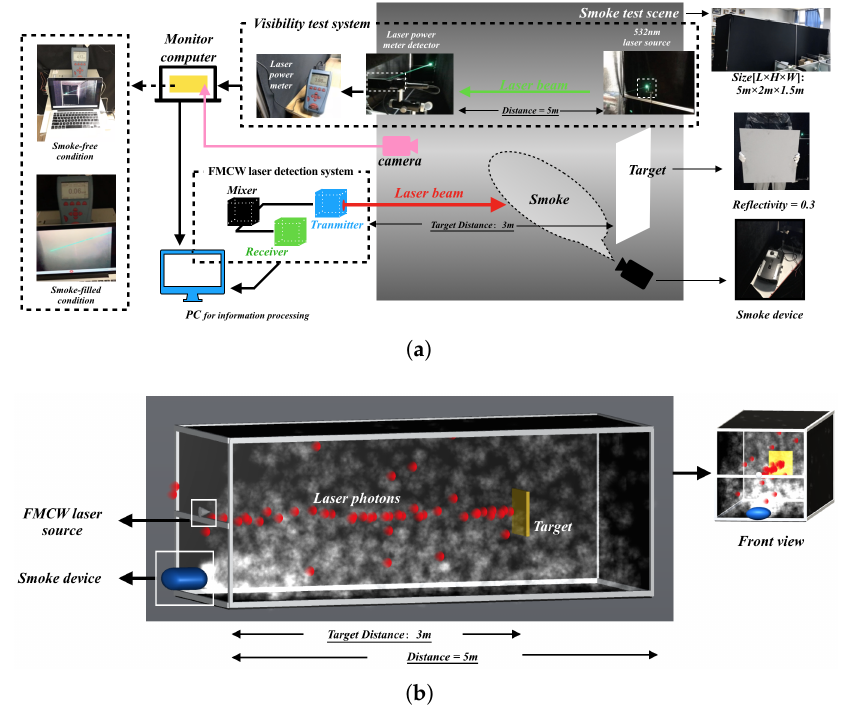
Figure 15. Setup and process of laser prototype test and virtual particle system simulation: ( a ) Laser prototype test; ( b ) virtual particle system